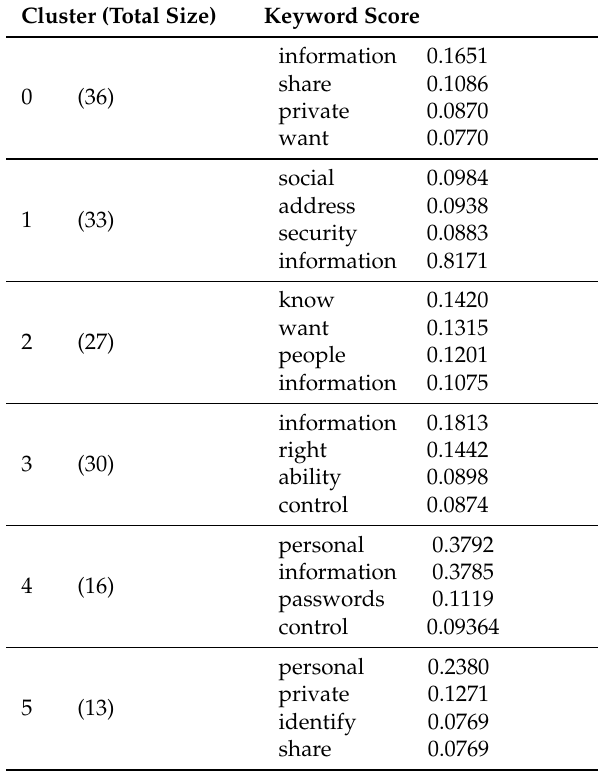
Table 3. Cluster breakdown of the top terms used to define privacy using average TF-IDF